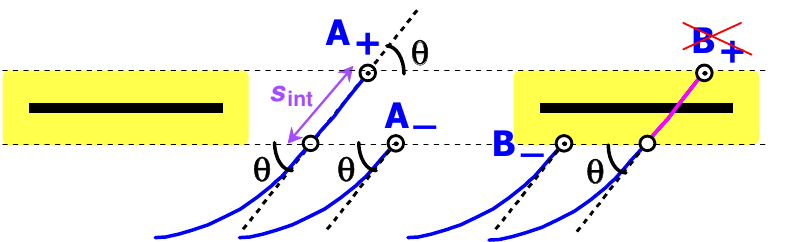
Figure 6. Clarification on Equation (71): The chain ending at point A + above the membrane intersects it through a hole. Otherwise, the conformation of this chain is similar to that of the chain A − which ends below the membrane thus avoiding the last intersection. In analogy with Figure 2 the partition functions ( ψ ) of the chains A − and A + are nearly equal, and the same is true, of course, for the chains A − and B − . By contrast, the partition function of the chain B + is zero since intersections of a solid part of the membrane are not allowed. On averaging over the film area, these relations lead to Equation